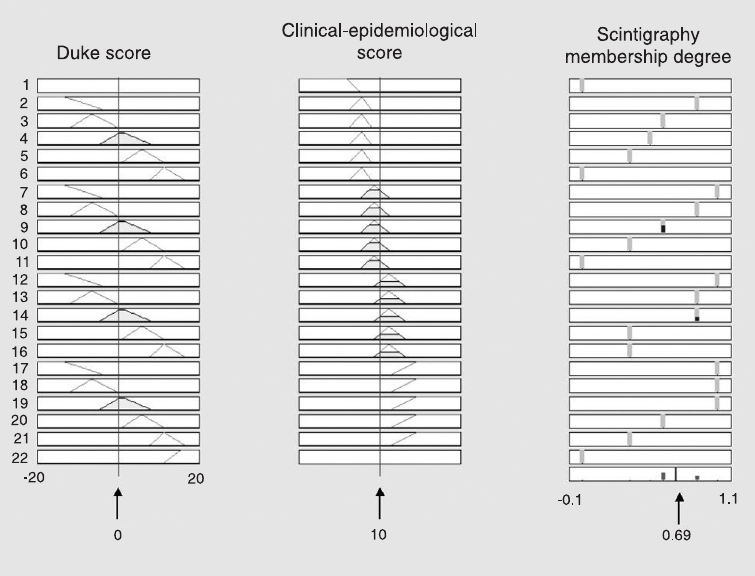
Figure 2. An example of a hypothetical patient presenting a Duke score of 0 and a clinical- epidemiological score of 10. Two fuzzy rules are activated (9 and 14) with different degrees. The final fuzzy score for this patient will be 0.69 (arrow). This value is derived from the weighted mean of the two activated rule